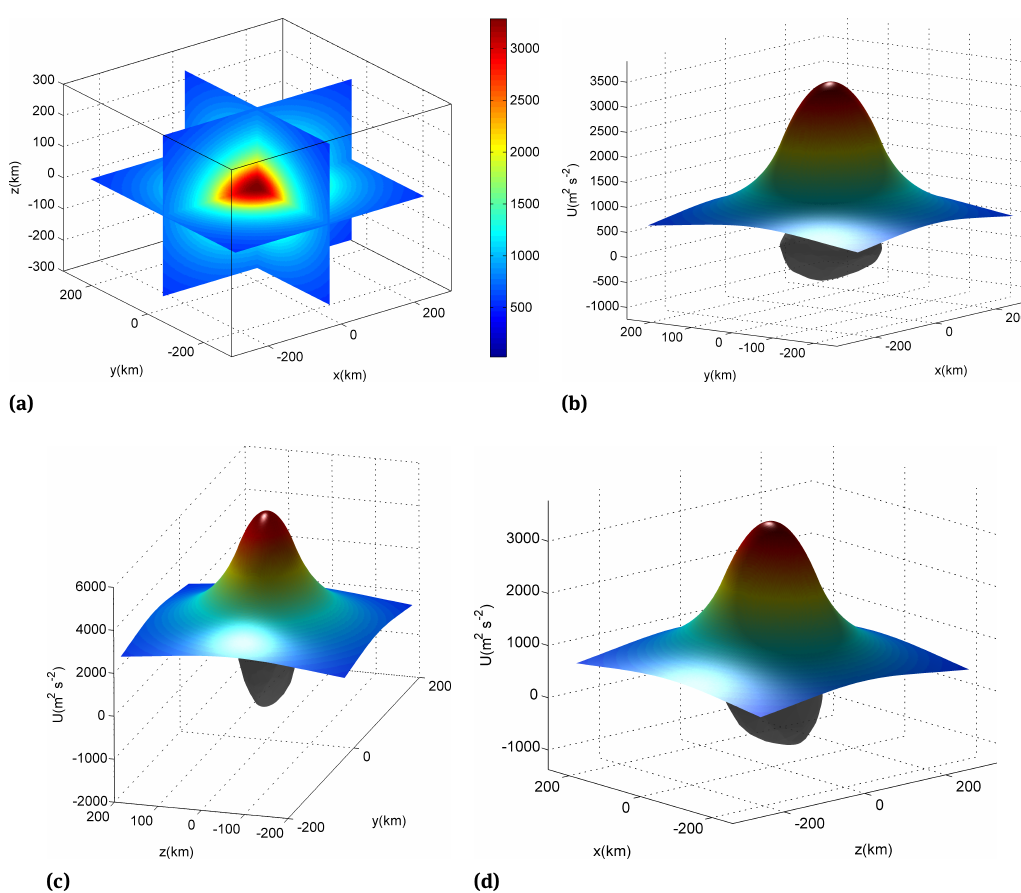
Figure 1. Gravitational potential around asteroid 45 Eugenia. (a) 3D plot of the gravitational potential, the unit of the gravitational potential is m 2 s −2 ; (b) The gravitational potential in the equatorial plane of the body-fixed frame; (c) The gravitational potential in the yz plane of the body-fixed frame; (d) The gravitational potential in the zx plane of the body-fixed frame.